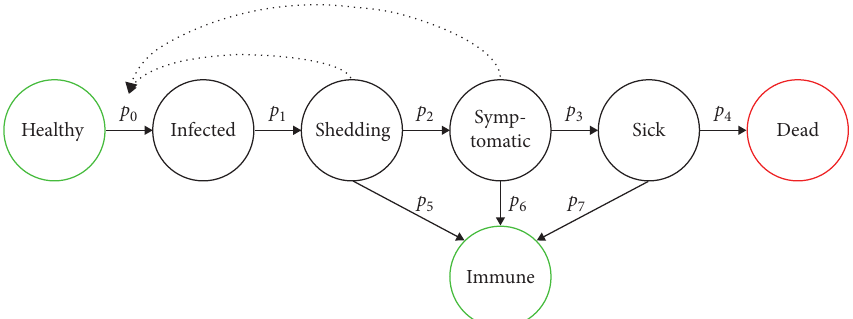
Figure 1: A Markov chain model describing how individuals can transition between states after